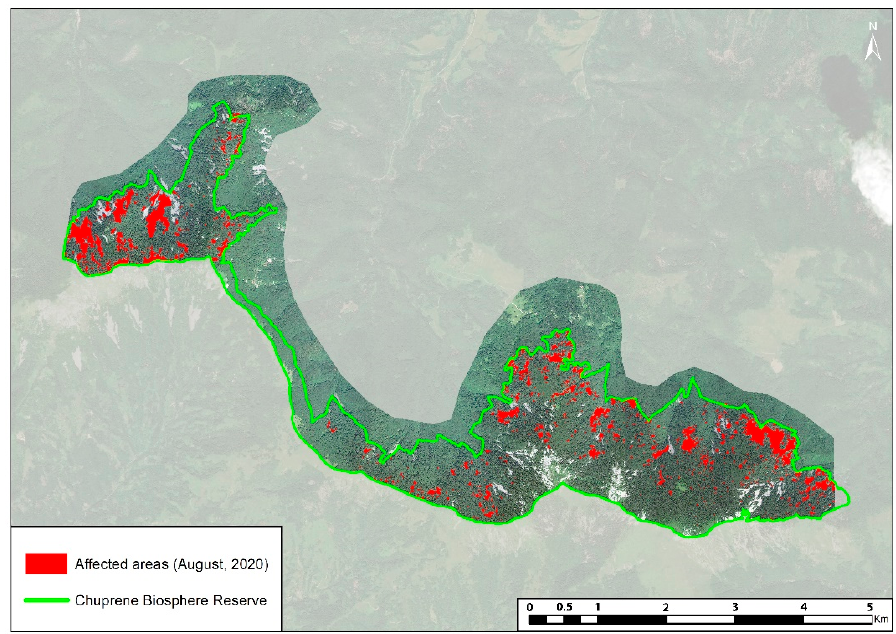
Figure 7. Ips typographus spots in the Chuprene Reserve in 2020 (satellite images).